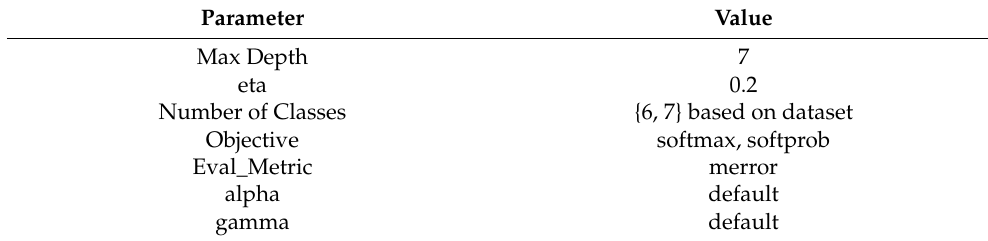
Table 5. Parameters Used for